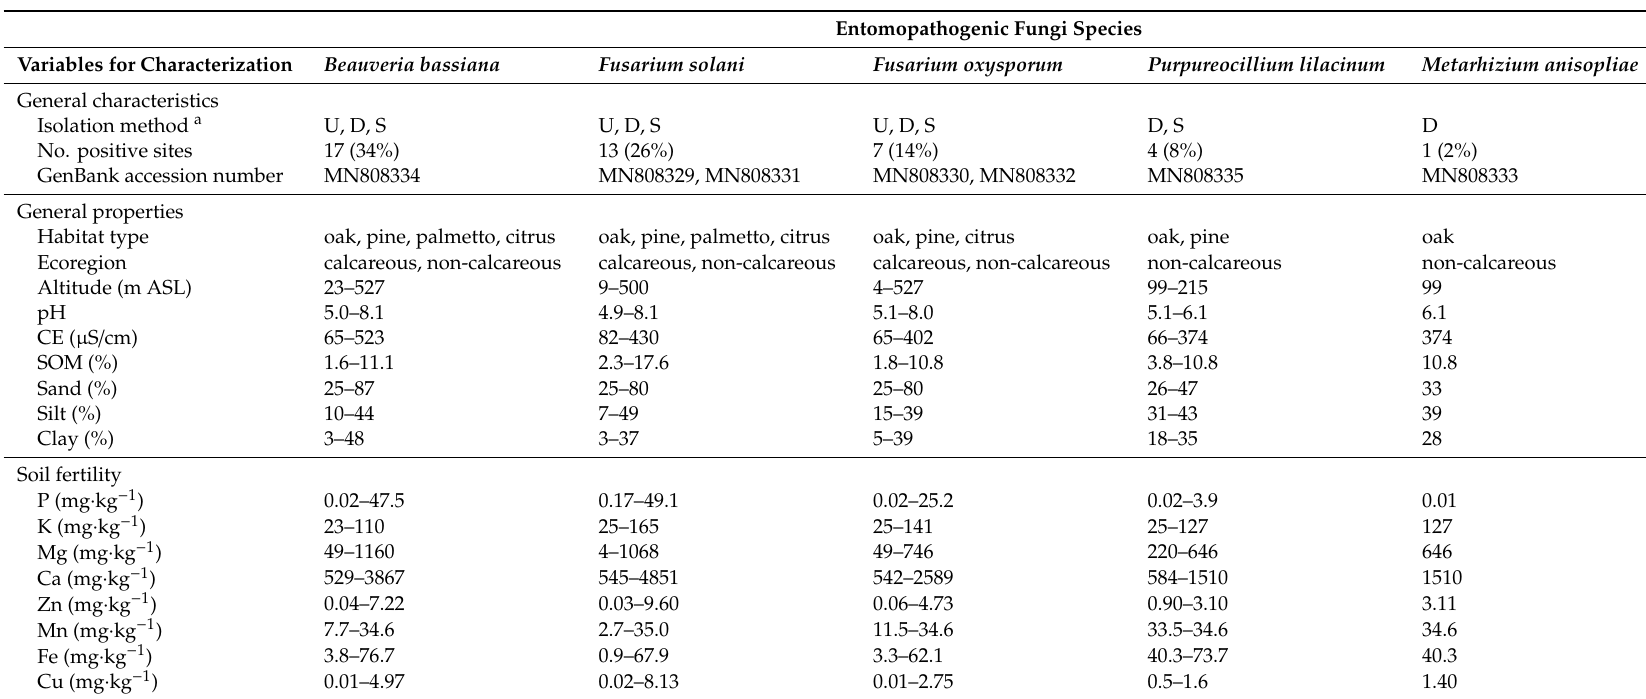
Table 1. Summary of soil properties and general characteristics associated with entomopathogenic fungi (that confirmed Koch’s postulates) isolated in the Algarve